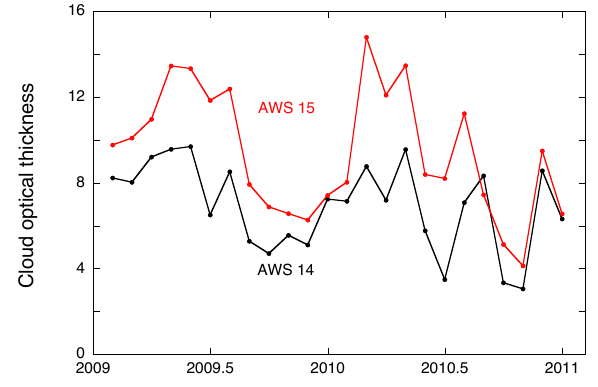
Fig. 5. Monthly means of cloud optical thickness (see text) at AWS 14 (black) and 15 (red). Table 2. Means of SEB components 1 February 2009–31 Jan- uary 2011 for AWS 14, in Wm − 2 . ANN = average over all